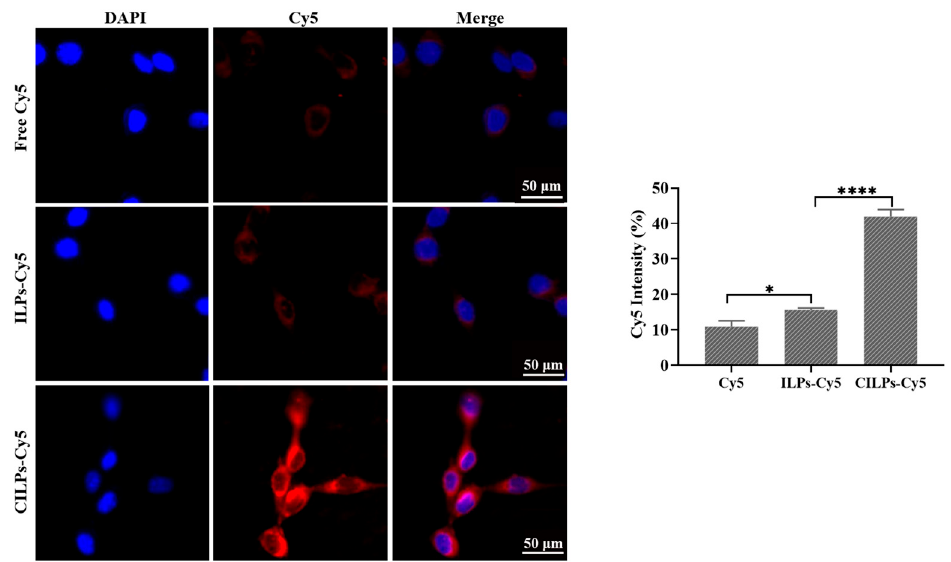
Figure 2. The images of CT26.WT cells after incubation with the free Cy5, ILPs-Cy5, and CILPs-Cy5 (red) for 0.5 h, and staining with DAPI (blue). Scale bar: 50 µm. ( n = 3). * p < 0.05; **** p < 0.0001.